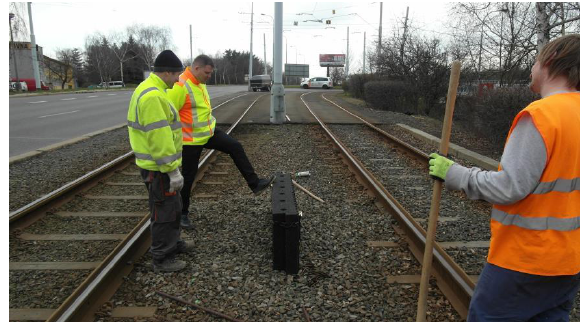
Figure 3. Mounting of MNAS prototypes – Vandal resistance